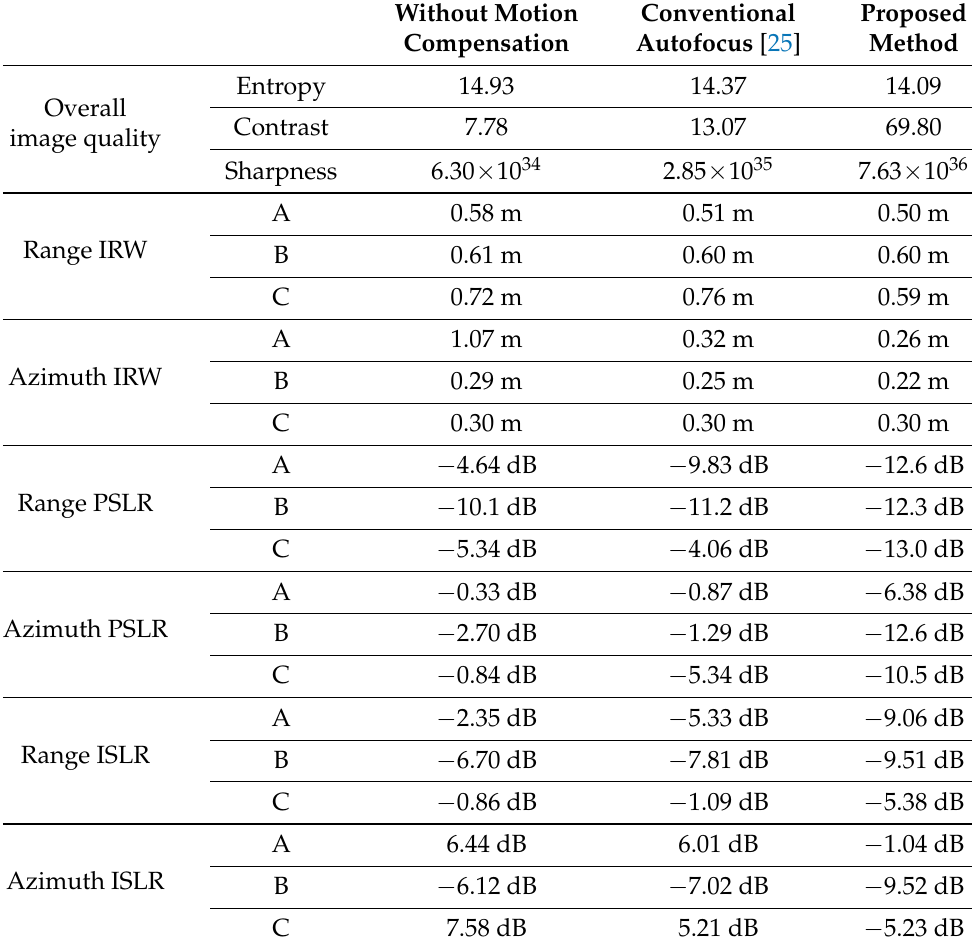
Figure 16. Profile properties of the processing results on the real experimental data: ( a ) range profiles of A; ( b ) range profiles of B; ( c ) range profiles of C; ( d ) azimuth profiles of A; ( e ) azimuth profiles of B; ( f ) azimuth profiles of C. Table 4. Processing performance on the experimental